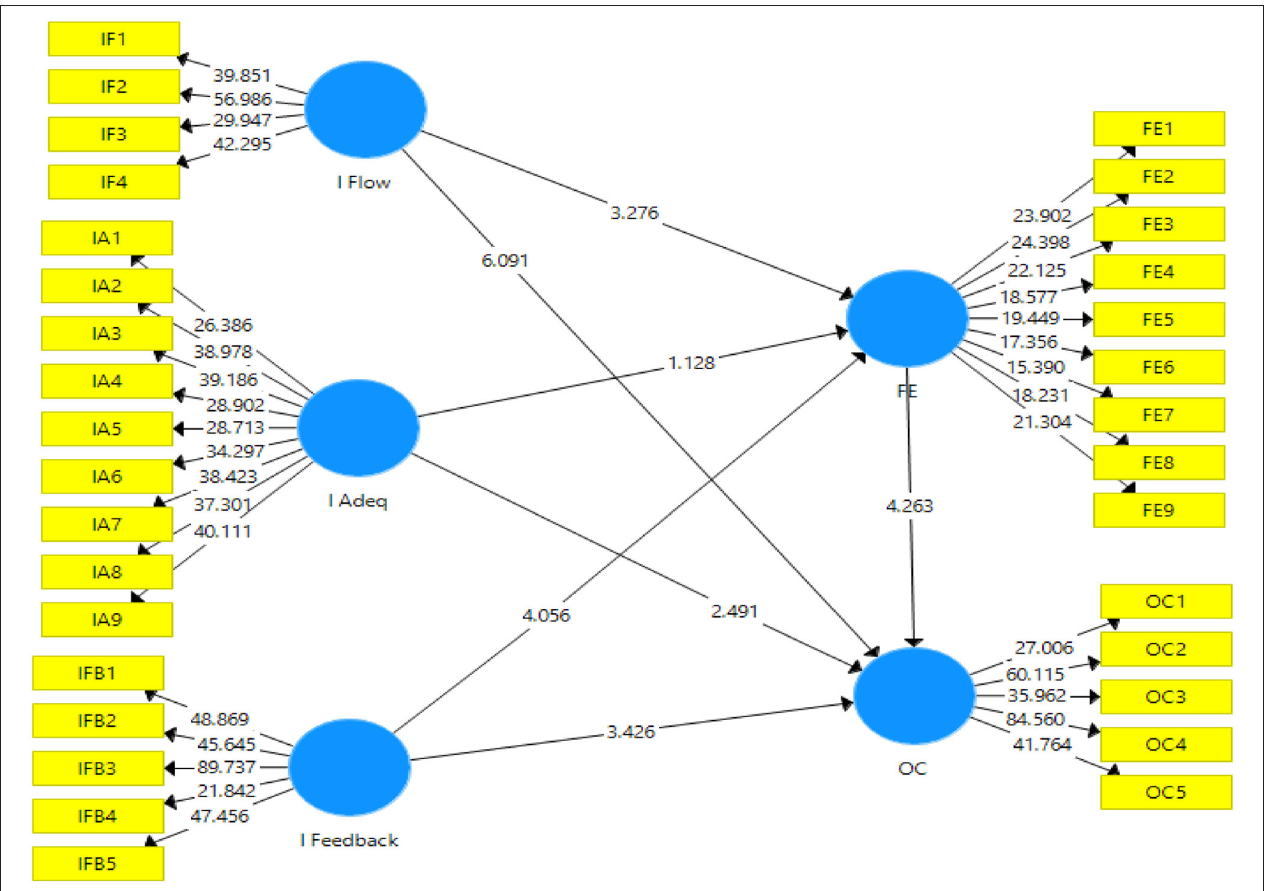
FIGURE 3 | Structural model bootstrapping. IFlow, Information flow; IAdeq, Information adequacy; IFeedback, Information feedback; FE, Faculty engagement; OC, Organizational commitment.